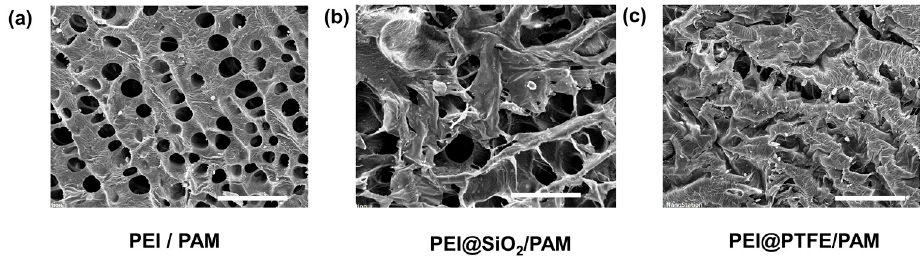
Figure 6. SEM images of freeze-dried ( a ) PEI/PAM ( b ) PEI@SiO 2 /PAM ( c ) PEI@PTFE/PAM hydrogels obtained through the dough-making process combined with UV curing, the scale bar is 100